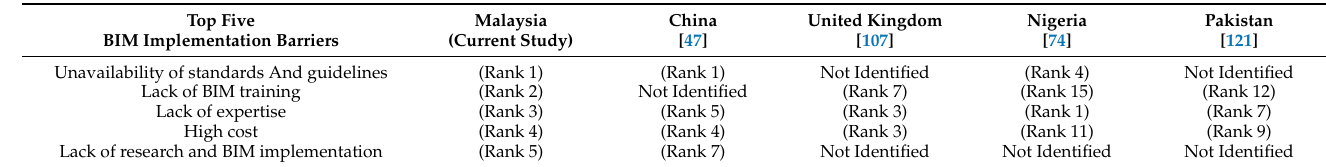
Table 6. Comparison of BIM implementation